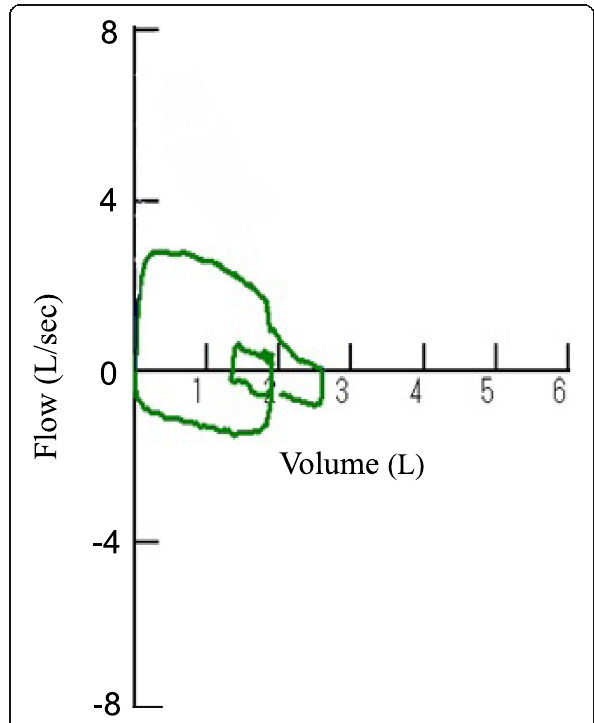
Fig. 2 Preoperative pulmonary function test. The flow-volume curve showed a characteristic fixed upper airway obstruction